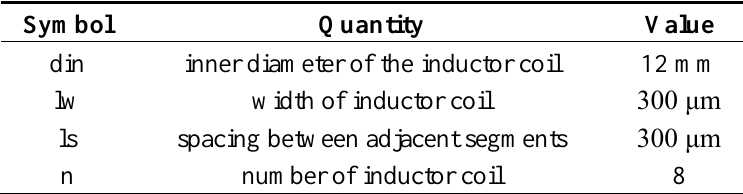
Table 1. Geometrical parameters of inductor design.